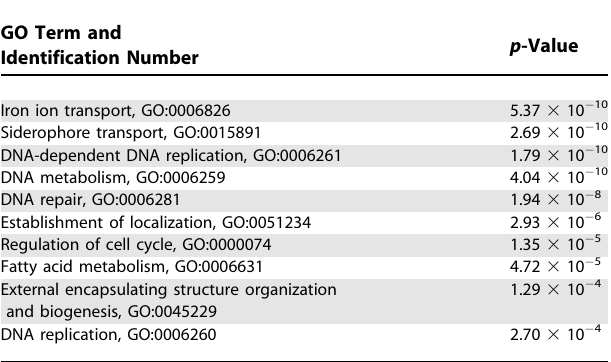
Table 2. The Top Ten GO Terms Identified by Gene Score